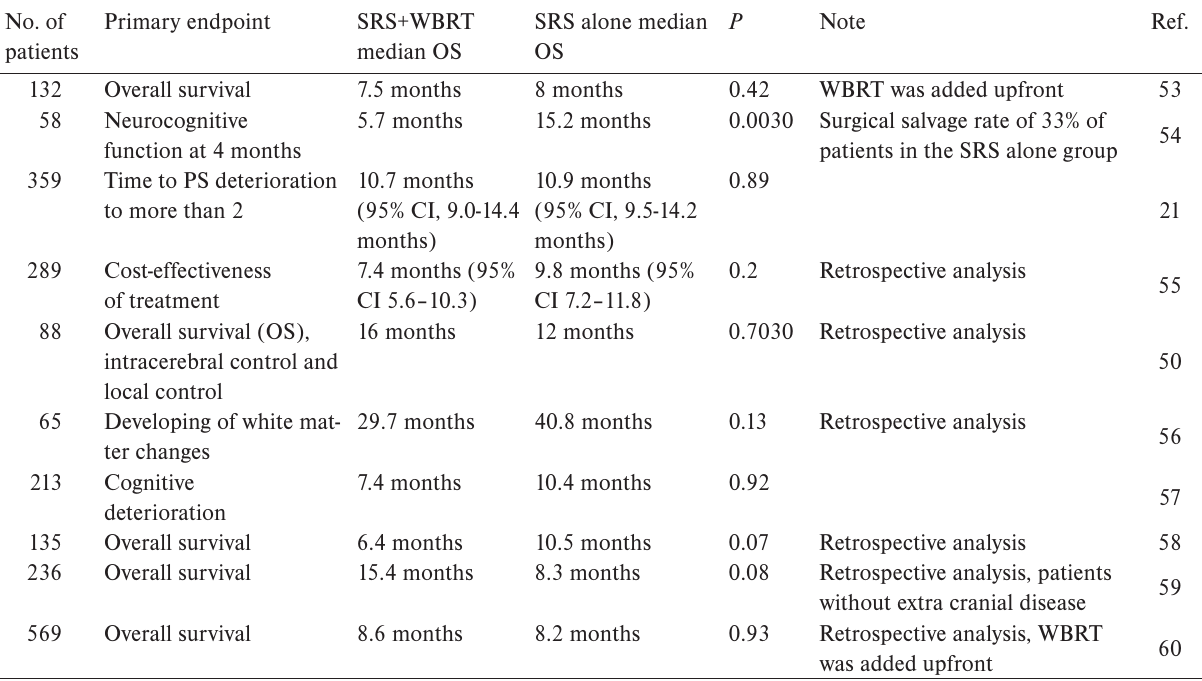
Table 2. Overview of studies comparing SRS plus WBRT versus SRS